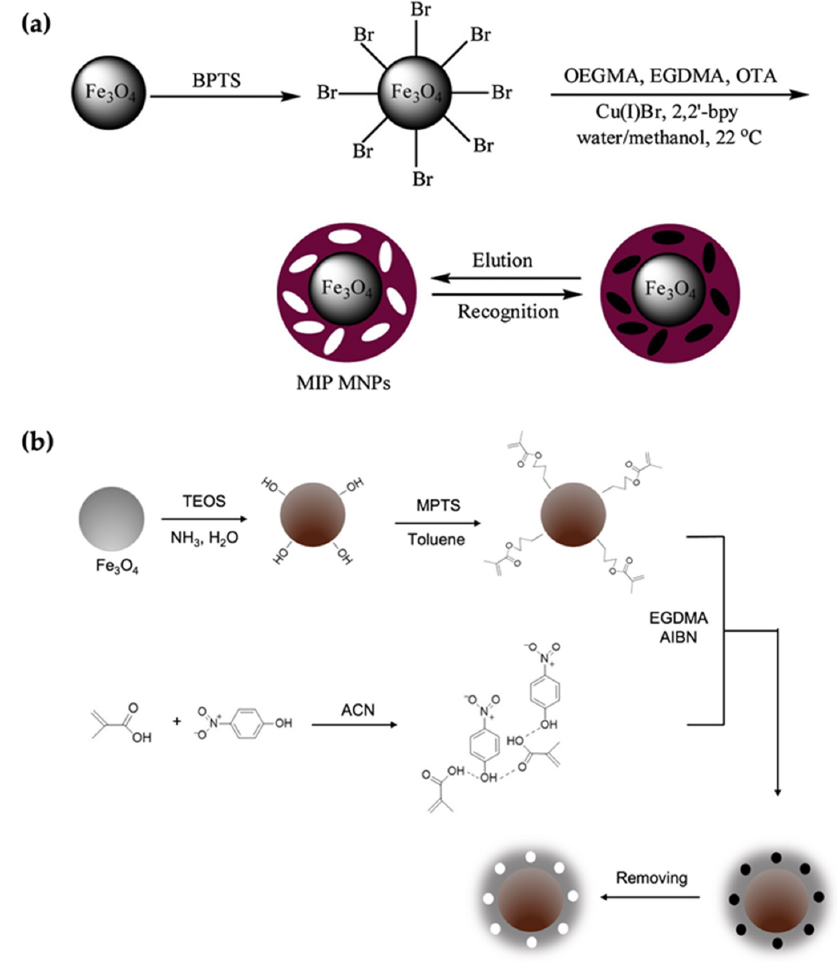
Figure 5. ( a , b ) The formation mechanisms of the surface imprinting process use the “grafting-from” technique. Reproduced with permission from [59,60], respectively.